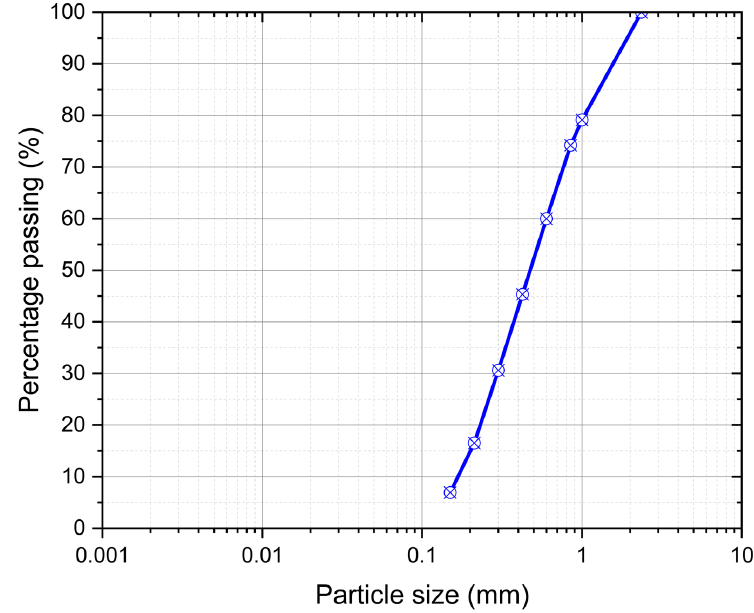
Figure 4. Particle size distribution for the natural soil .